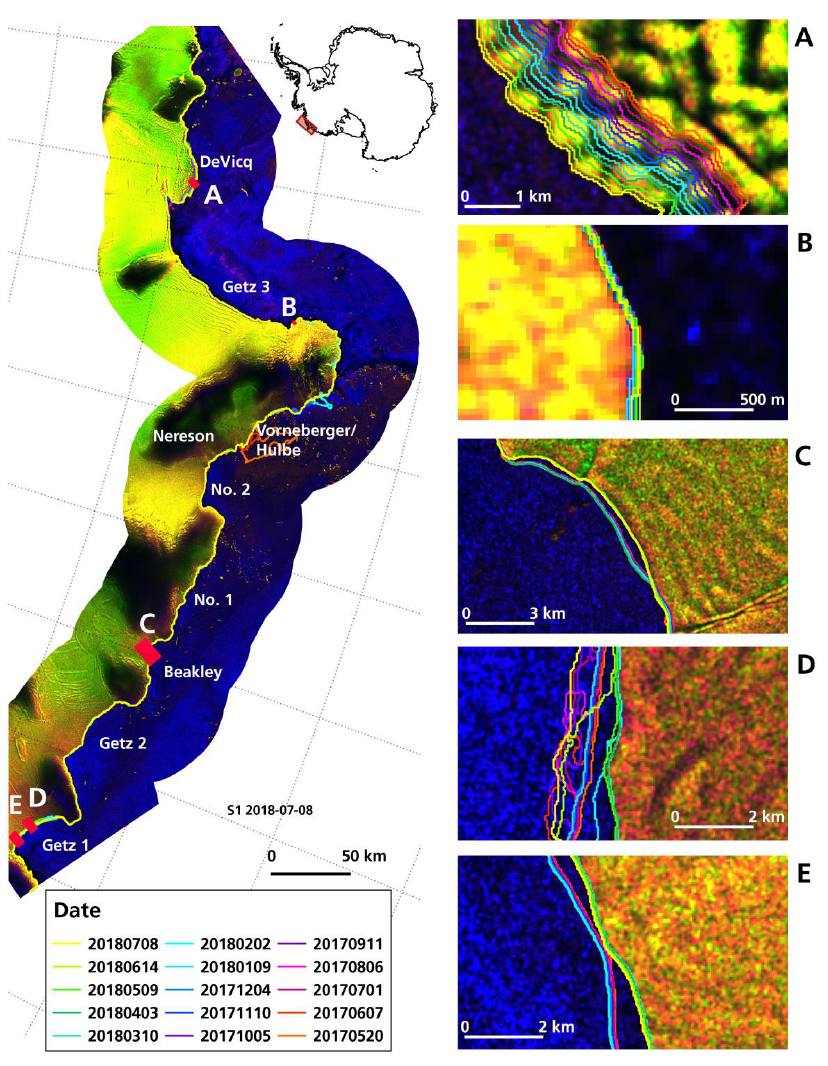
Figure 6. Extracted time series along the Getz Ice Shelf. ( A ) Continuous advance of the DeVicq Glacier. Figure 6 Extracted time series along the Getz Ice Shelf. ( a ) Continuous advance of the DeVicq Glacier. ( B ) Part of a stable coastline. ( C ) Front of the Beakley Glacier showing a calving event. Front of Getz 1 ( b ) Part of a stable coastline. ( c ) Front of the Beakley Glacier showing a calving event. Front of Getz 1 with wrong delineation in ( d ) and calving event in ( e ). Sentinel-1 scene from 2018-07-08. RGB: HH, with wrong delineation in ( D ) and calving event in ( E ). Sentinel-1 scene from 2018-07-08. RGB: HH, HV, HV/HV. HV, HV / HV.